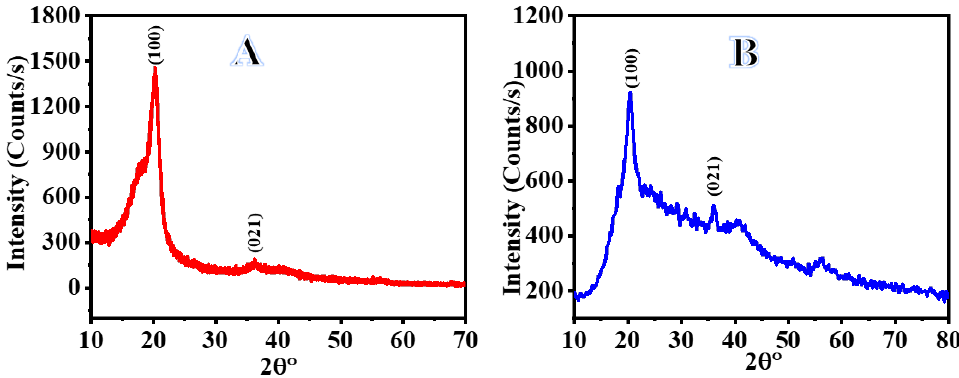
Figure 4. XRD charts of PVHF ( A ) and PVHF-40 ( B ) membranes. TGA charts (Figure 5) were used to investigate the thermal decomposition of PVHF and Co@PVHF membrane NFs. Bare PVHF film had a distinct weight loss region at 420 ◦ C as a result of the stochastic bond cleavage of its units during decomposition [60,61]. After cobalt species were introduced into the PVHF film, this transition was seen at 346 ◦ C, in addition to a little shift observed at 95 ◦ C, which could be due to the evaporation of physisorbed water. The van der Waals forces between the chains of this polymeric membrane were reduced due to the incorporation of cobalt nanoparticles into its structure. As a result, metal-supported polymeric membranes degraded at lower temperatures compared to naked mat [62].